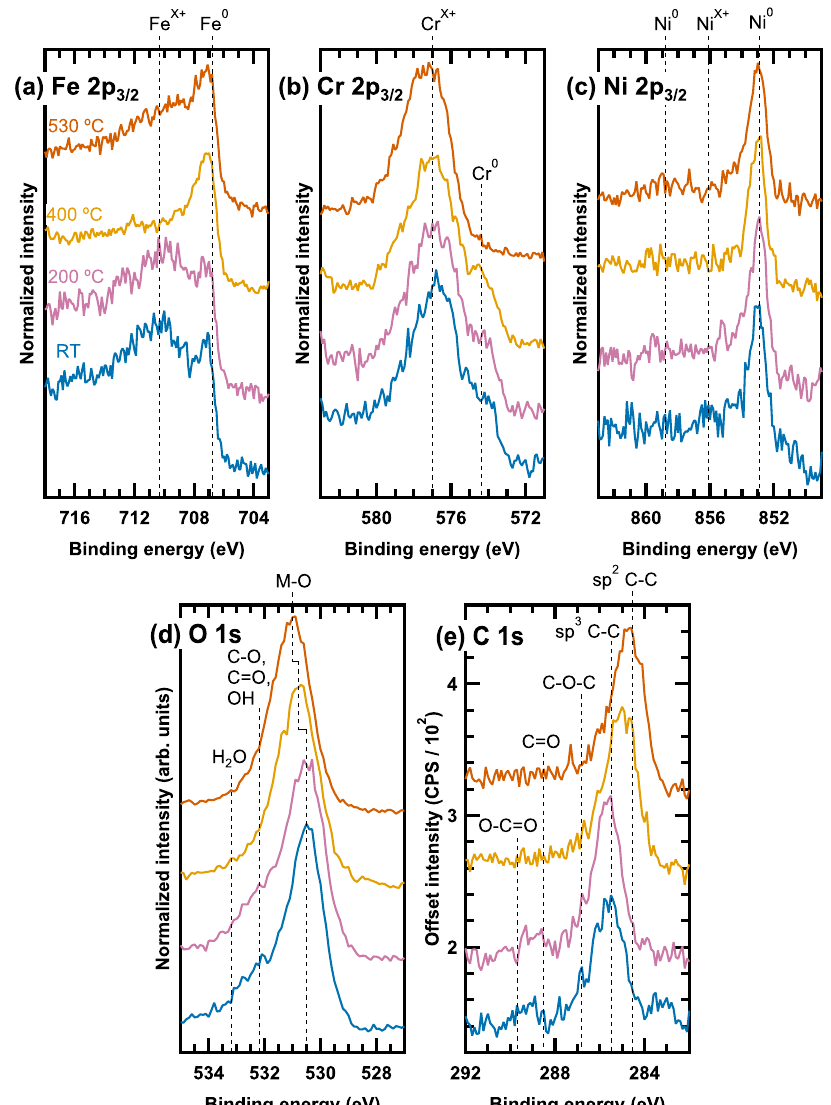
Fig. 2 AP-XPS spectra of Fe22Ni22Cr exposed to high purity CO 2 . a Fe 2p 3/2 . b Cr 2p 3/2 . c Ni 2p 3/2 . d O 1s. e C